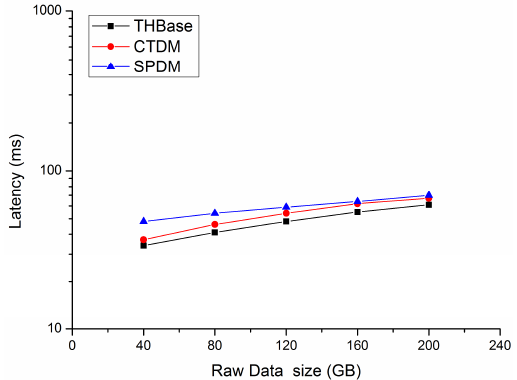
Figure 5. Performance of single-object query.